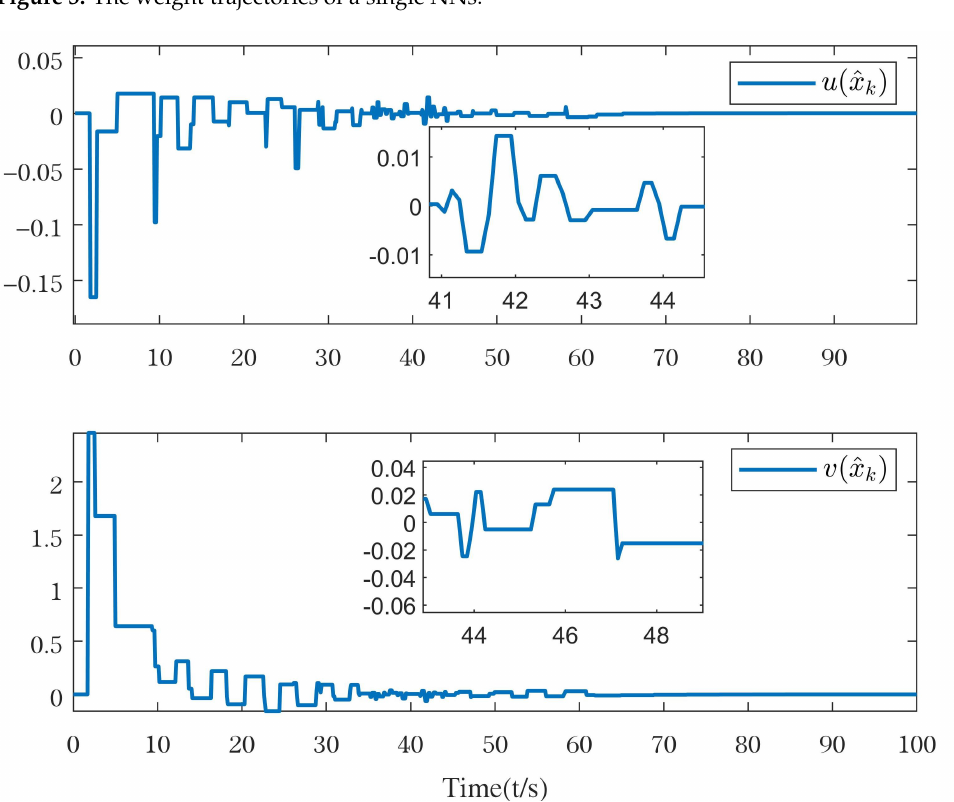
Figure 4. The control law u ( ˆ x k ) and the perturbation law υ ( ˆ x k )